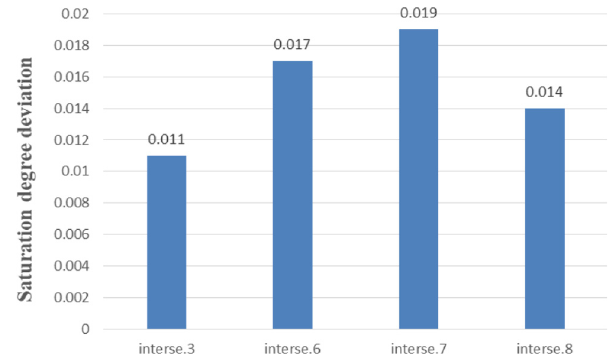
Table 4 Adjusted timing plans in different cycles for a bus Intersection no.